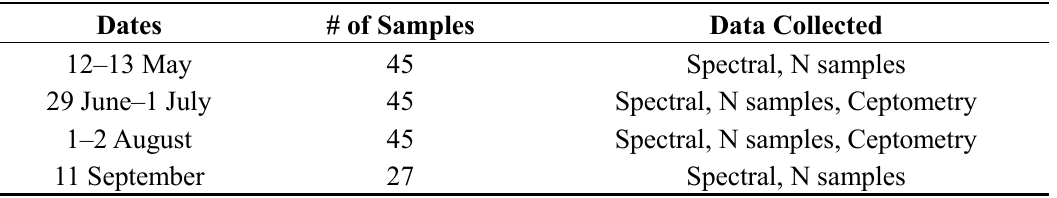
Table 1. Datasets of in situ